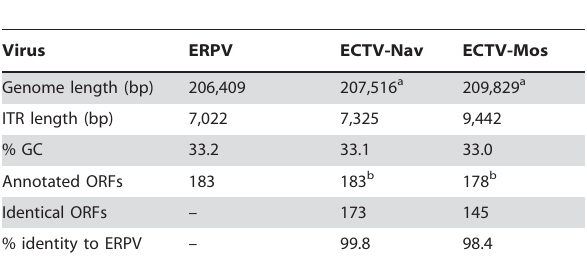
Table 1. Comparison of genomes of ERPV and ECTV-Nav and ECTV-Mos.